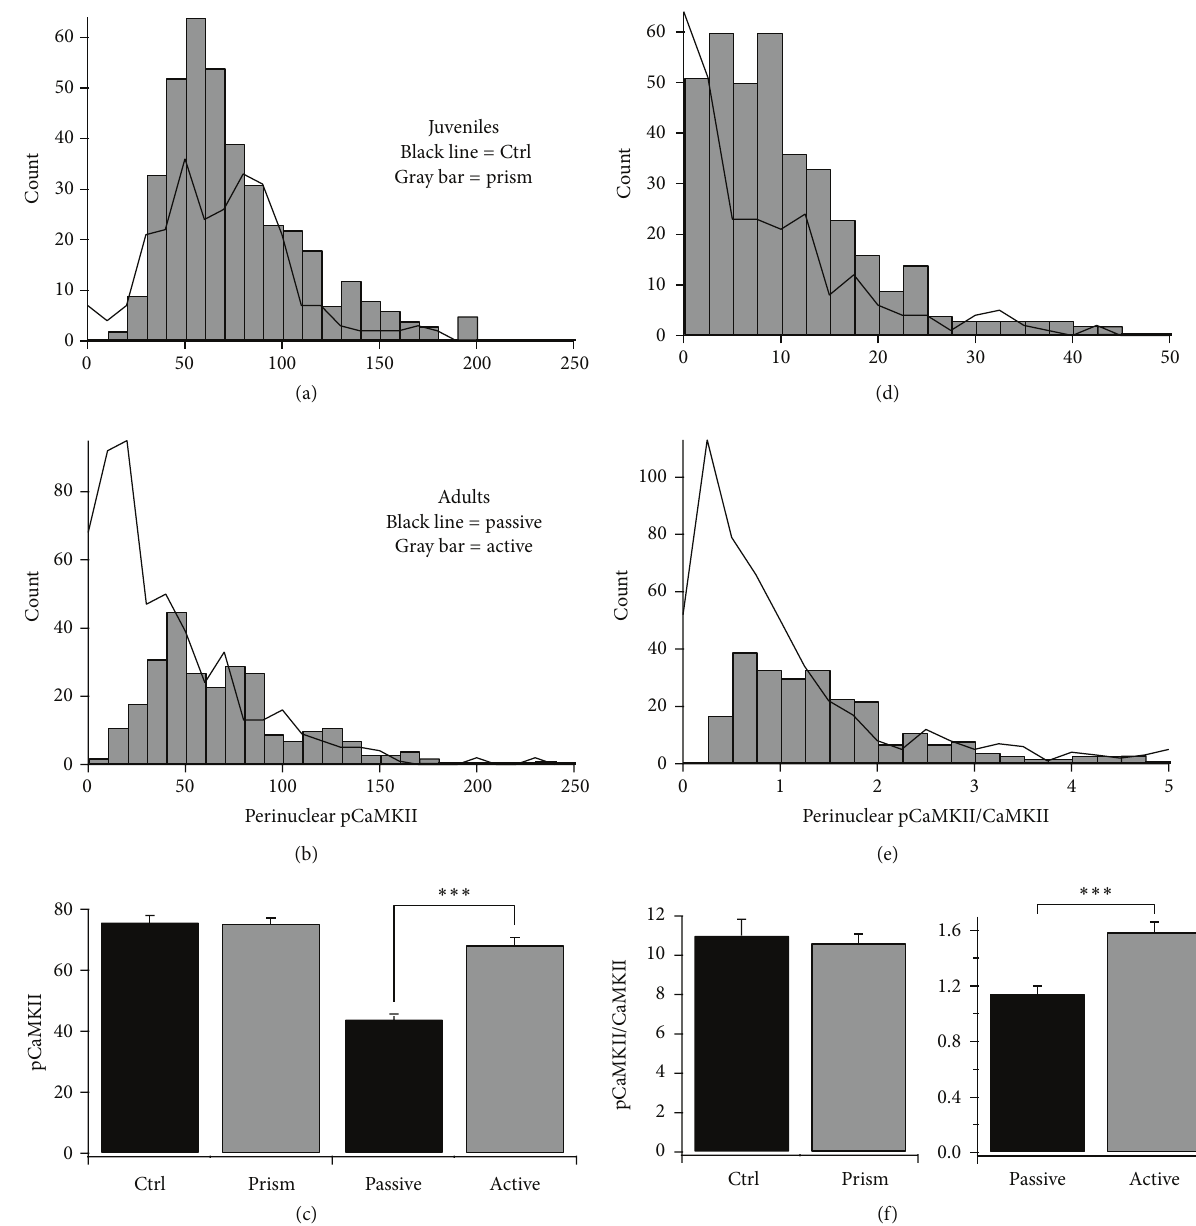
Figure 4: Experience-dependent regulation of perinuclear pCaMKII. Left panels , frequency histograms of perinuclear pCaMKII signal in (a) Ctrl versus prism juveniles and (b) passive versus active adults. (c) Mean values for all four experimental groups. No difference was observed between controls and prism-wearing juveniles (Mann-Whitney 𝑈 test, 𝑃 = 0.29 ). In contrast, active hunting in adults significantly increased perinuclear pCaMKII intensities ( ∗∗∗ 𝑃 < 0.0001 for Mann-Whitney 𝑈 test). Right panels , frequency histograms of perinuclear pCaMKII/CaMKII signals in (d) Ctrl versus prism and (e) passive versus active. (f) Mean values for all four experimental groups. A small magnitude difference was observed between Ctrl and prism juveniles but was not significant (Mann-Whitney 𝑈 test, 𝑃 = 0.02 ). In contrast, active hunting in adults significantly increased perinuclear pCaMKII/CaMKII signals ( ∗∗∗ 𝑃 < 0.0001 for Mann-Whitney 𝑈 test). All data in this figure is case normalized within experimental group: control juveniles (262 cells), prism-wearing juveniles (392 cells), passive adults (525 cells), and active adults (270